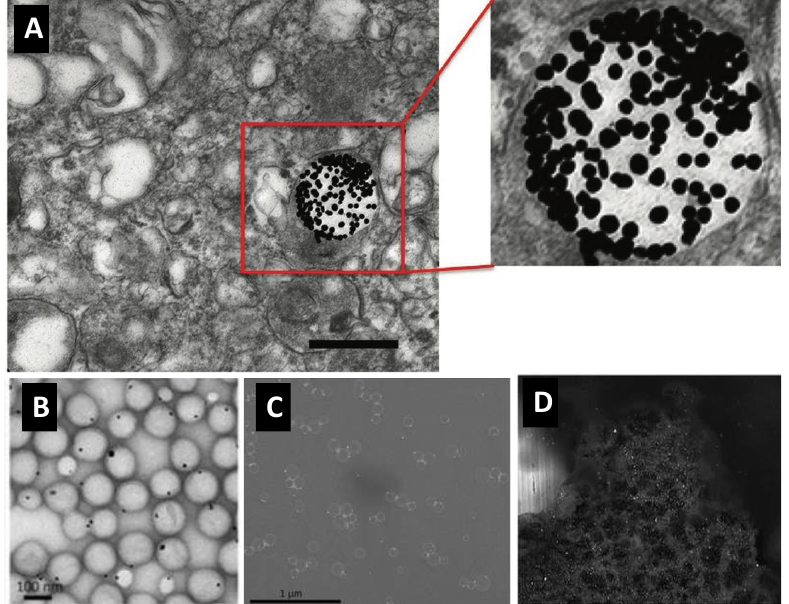
Figure 3. Poly(lactic-co-glycolic acid) (PLGA) nanoparticles labeled with gold nanoprobes to track their nano-bio interaction: ( A ) TEM image showing single PLGA nanocarrier labeled with spherical GNP (15 nm) taken up by HeLa cancer cell, scale bar = 150 nm. ( B ) TEM image and ( C ) SEM backscattered electron image of one-to-one encapsulation of gold nanoprobes into PLGA carriers that allows for the tracking of the labeled PLGA carriers inside J774 cells ( D ) using SEM analysis with backscattered electron detection mode. ( A ) Reproduced with permission from [28], published by John Riley and Sons, 2019. ( B – D ) Reproduced with permission from [29] published by Elsevier, 2017.